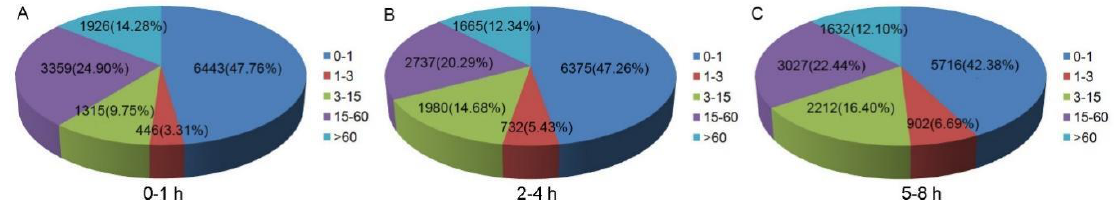
Figure 1. Fragments Per Kilobase of transcript per Million mapped reads (FPKM) distribution of the B. dorsalis early embryo transcriptomes.